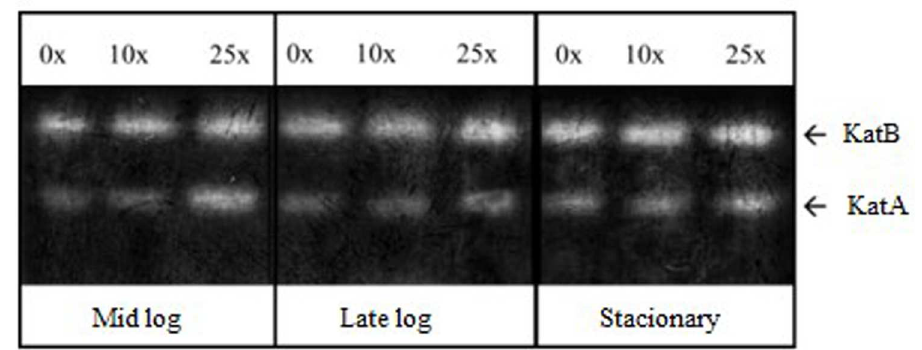
Fig 7. Characterization of CAT isoforms in PAGE, which were obtained from the extracts of Pseudomonas sp. CMA 7.3 undergoing treatments with 0x, 1x, and 25x concentrations of 2,4-D from samples obtained in the mid- log, late-log, and stationary